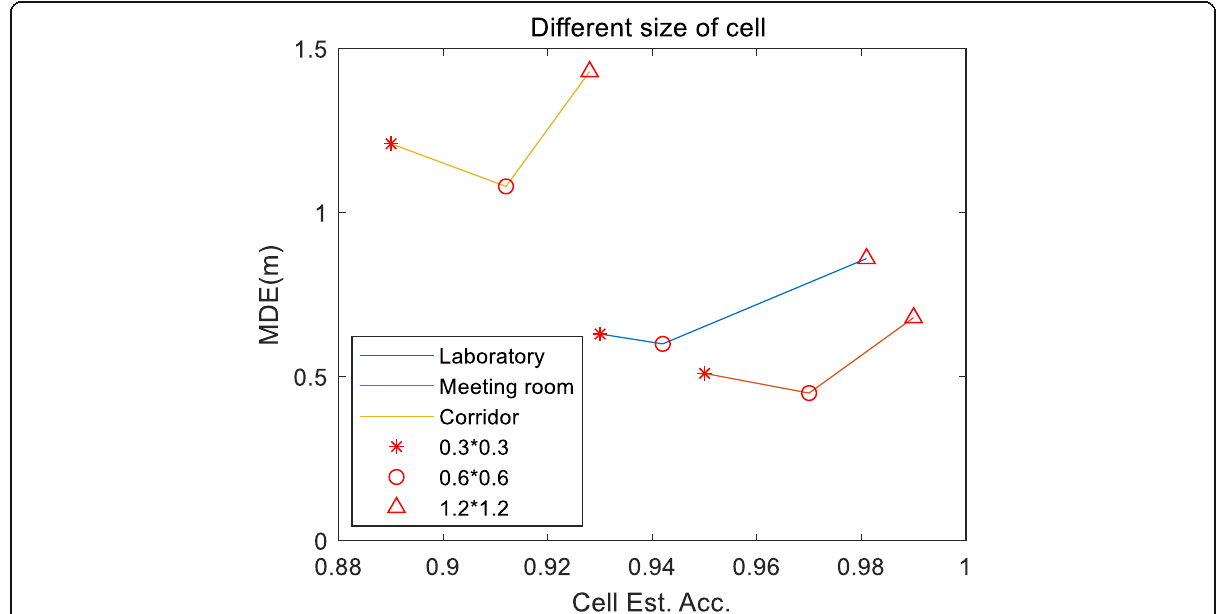
Fig. 11 Different size of cell. In the figure, blue, orange, and yellow line represents the experiment scenarios. Blue represents the experiment done in the laboratory, orange line represents the experiment done in the meeting room and yellow line represents the experiment done in the corridor. Star represents the size of cell is 0.3 m × 0.3 m, circular represents the size of cell is 0.6 m × 0.6 m, and triangle represents the size of cell is 1.2 m × 1.2